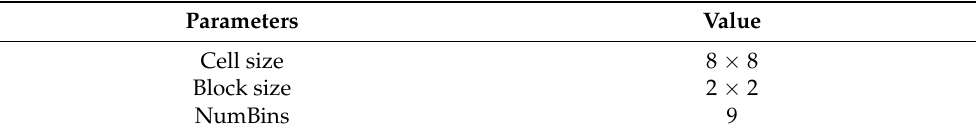
Table 1. Characteristic parameters of HOG algorithm.